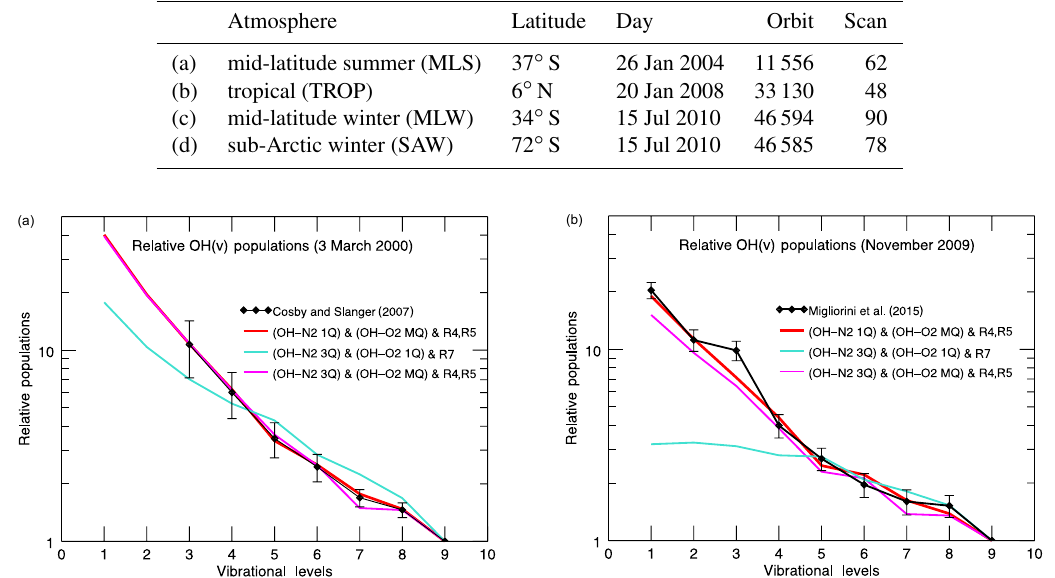
Table 2. Selected nighttime SABER scans.